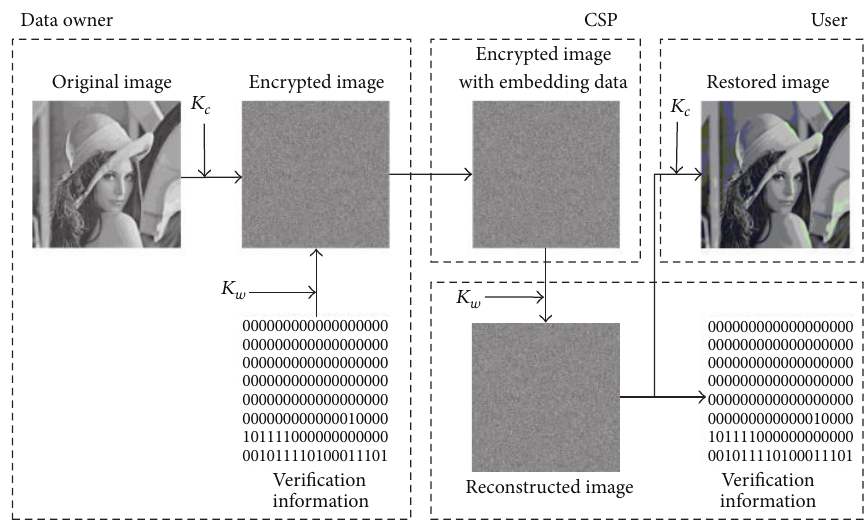
Figure 3: Experimental results of the proposed scheme.